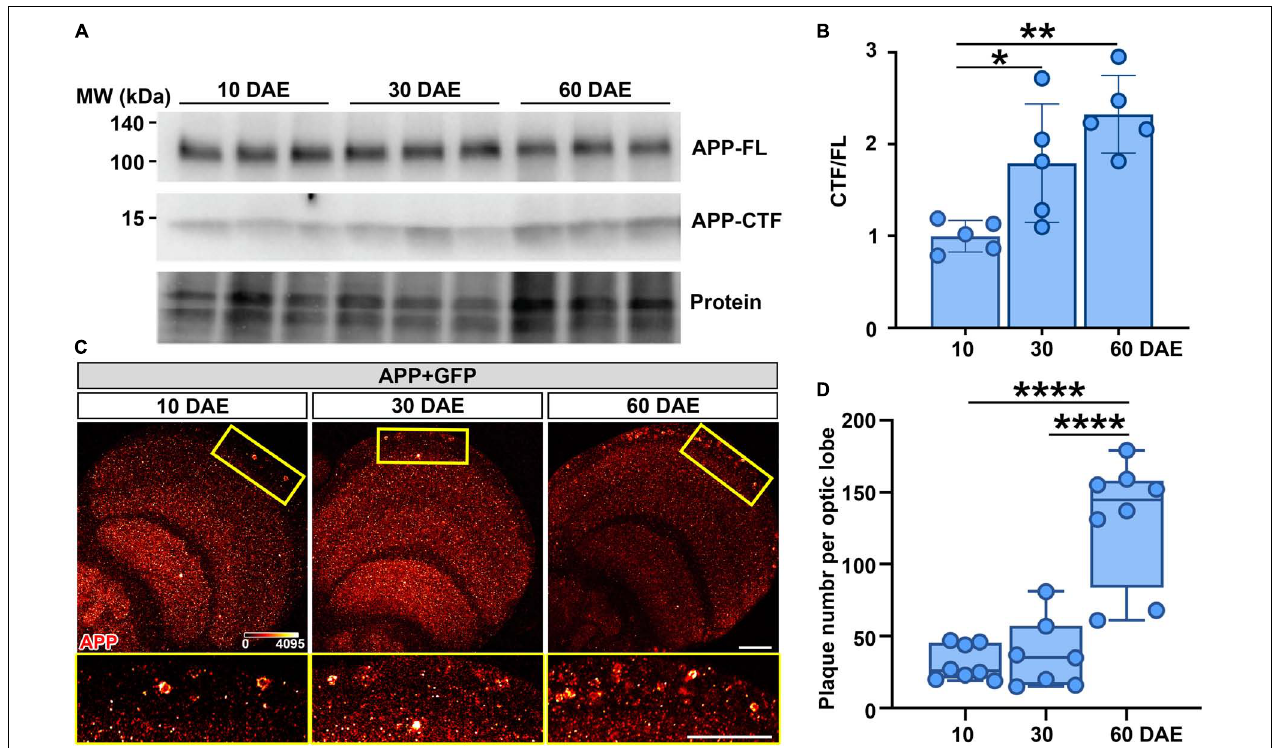
FIGURE 1 | Neuronal expression of APP and BACE1 leads to an age-dependent amyloid aggregation in the brain. (A) Western blot analysis showing full-length amyloid precursor protein (APP-FL) and C-terminal fragment (APP-CTF) of 10, 30, and 60 DAE flies expressing APP. Stain-Free imaging of a representative portion of the membrane is presented to show the protein loading. (B) Quantification of CTF/FL ratio in each group. Data are expressed as mean ± SD. n = 5/group. One-way ANOVA with Bonferroni’s post hoc test. * P < 0.05, ** P < 0.01. (C) Top row: fly brains at 10, 30, and 60 DAE stained with antibody anti APP (heatmap). Bottom row: higher magnification images of the boxed areas in the top row. Scale bars = 30 µ m. (D) Scatter plot showing quantification of the number of amyloid plaques in panel (C) . The whiskers represent the minimum and maximum values of the dataset. One-way ANOVA with Bonferroni’s post hoc test. n = 7–8/group, **** P <